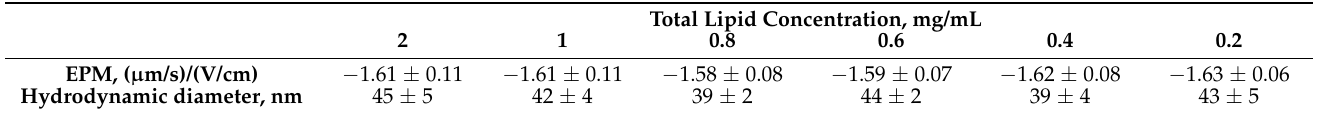
Table 2. EPM and particle size for POPC/AMS liposomes of different concentrations ( α = 0.1) obtained in a buffer with pH 8.4.